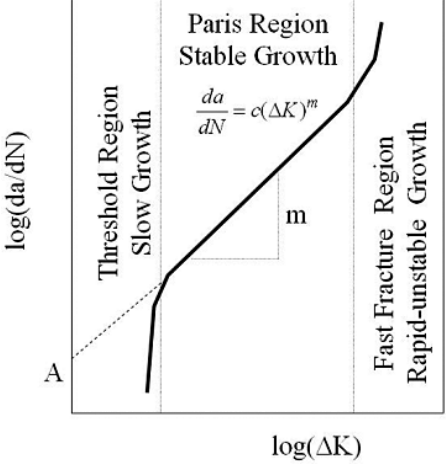
Fig. 2. Crack growth regimes, according to the Paris